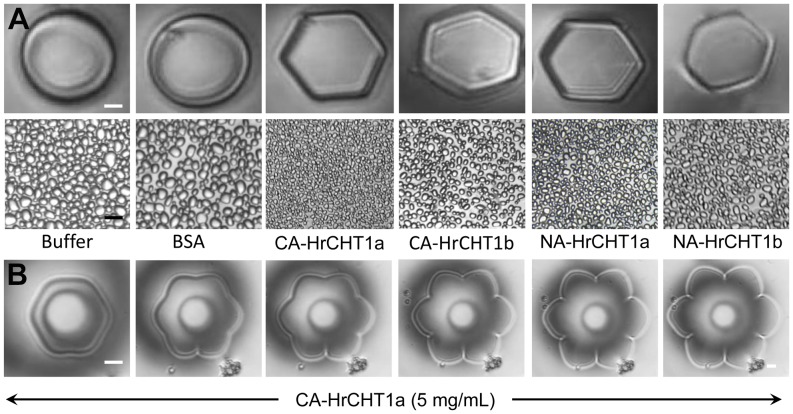
Analysis of antifreeze activity in HrCHT1a and HrCHT1b purified from cold acclimated and non-acclimated seedlings.(A) Upper panel-ice crystal morphology, analysed by phase contrast microscope attached with nanoliter osmometer. Lower Panel-Ice recrystallization inhibition assays as observed by sucrose sandwich splat assay. BSA was used a negative control which did not exhibit antifreeze activity. Magnification bar in ice crystal morphology shows 10 µm, while in splat assay it represents 50 µm. Error bars show standard deviation from five replicates. (B) Ice crystal morphologies showing different stages of formation of flower shaped ice crystal with 5 mg/mL HrCHT1a.